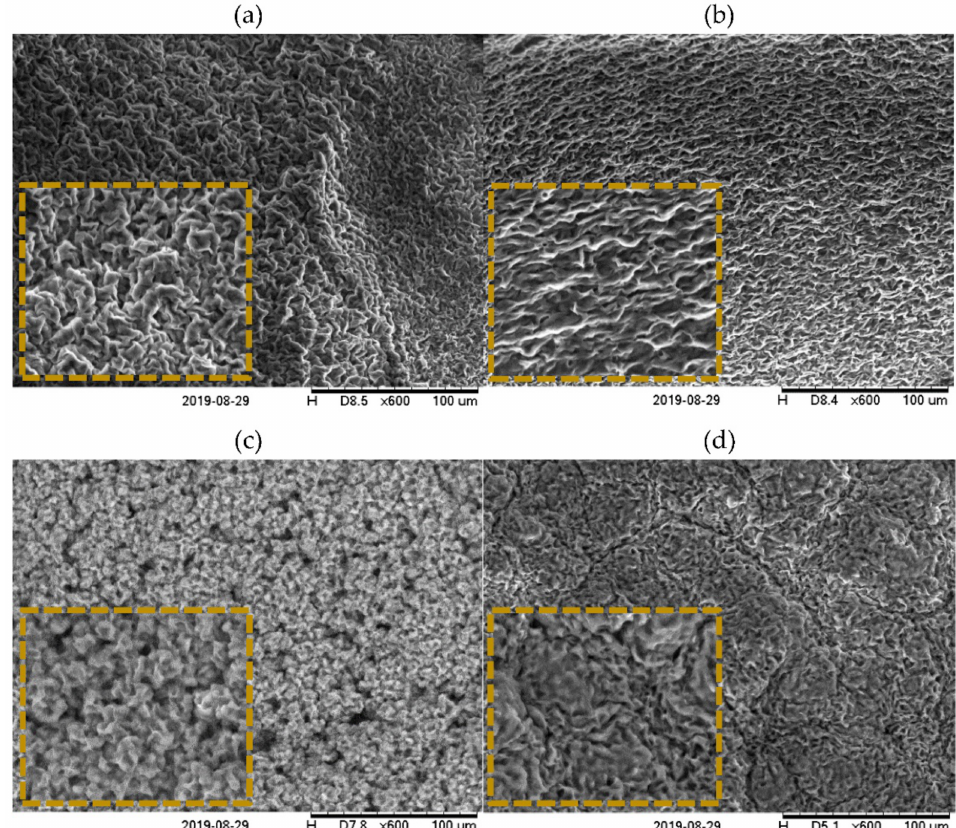
Figure 2. Scanning electronic microscopy (SEM) images of Beeswax olgeogel ( a ), 25:75 mixture of glycerol monostearate and beeswax ( b ), 25:75 mixture of glycerol monostearate and sunflower wax ( c ), and 50:50 mixture of glycerol monostearate and sunflower wax ( d ) oleogels. Magnification of 600 × . Scale equivalent to 100 µ m. The inset figures correspond to 1000 × magnification. Taken